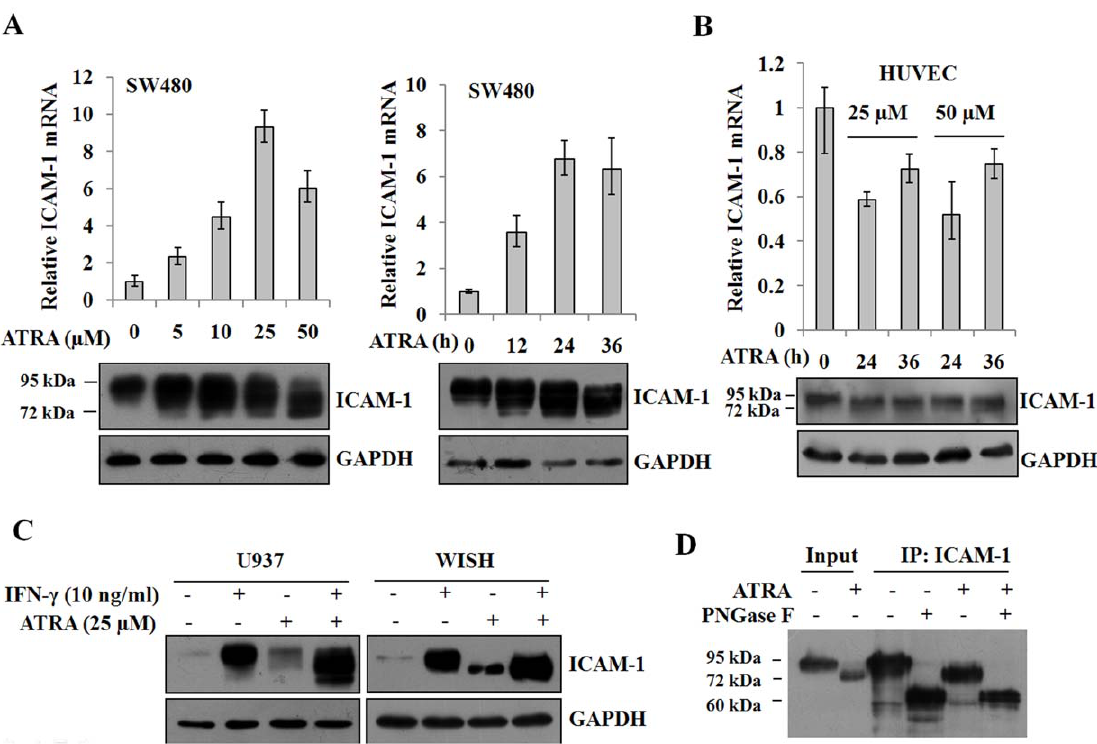
Figure 1. ATRA induces the expression and N -glycan modification of ICAM-1. A, SW480 cells were treated with 0, 5, 10, 25 and 50 m M ATRA for 36 h or with 25 m M ATRA for 0, 12, 24 and 36 h. The expression of ICAM-1 was analyzed by real-time RT-PCR (n=3) and Western blot. Equal loading was verified by detection of GAPDH. B, HUVEC cells were treated with 25 or 50 m M ATRA for 0, 24 and 36 h. The expression of ICAM-1 was analyzed by real-time RT-PCR (n=3) and Western blot. C, U937 and WISH cells were treated with either 10 ng/ml IFN- c or 25 m M ATRA or both. The expression of ICAM-1 was analyzed by Western blot. D, WISH cells were treated with 25 m M ATRA. The cell lysates were immunoprecipitated by the antibody against ICAM-1 and then treated with PNGase F. The digested samples were blotted and detected by Western